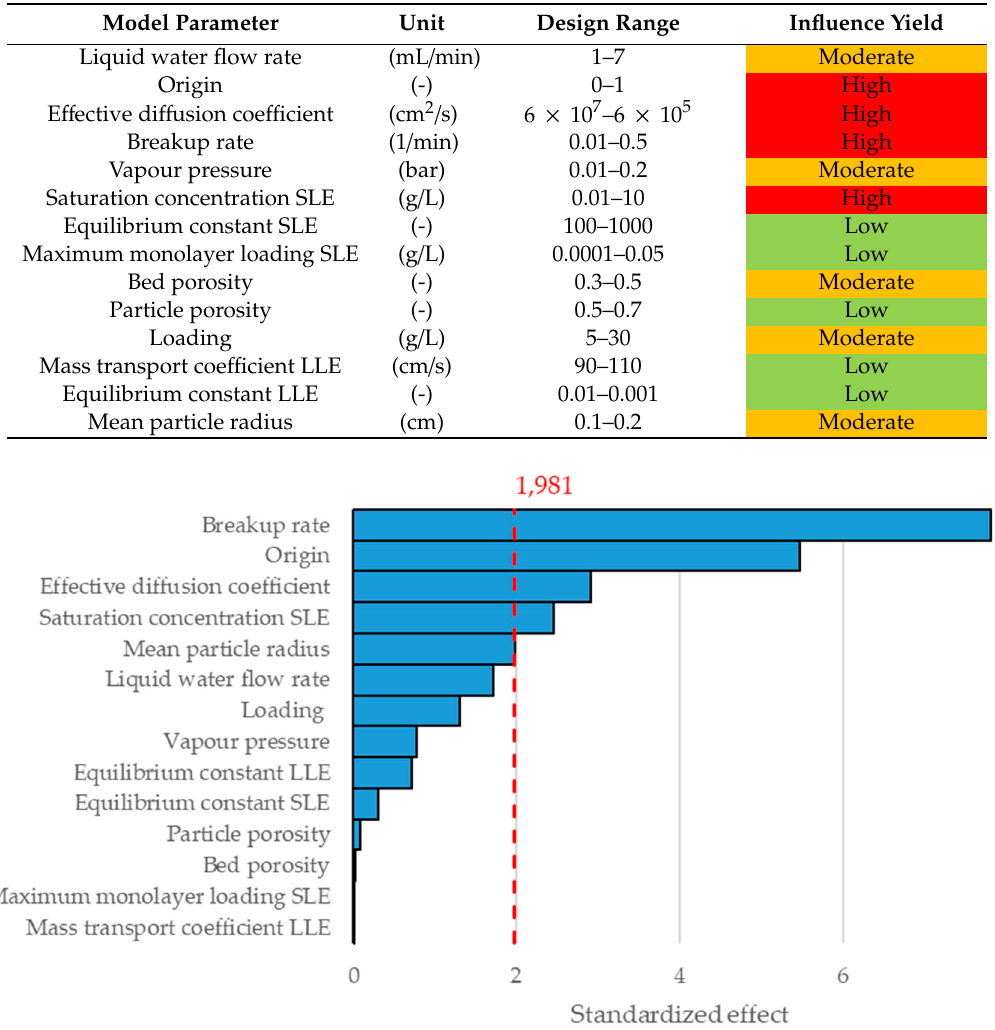
Figure 10. Pareto diagram of the standardised effects for the yield at 5 min (alpha = 5%).